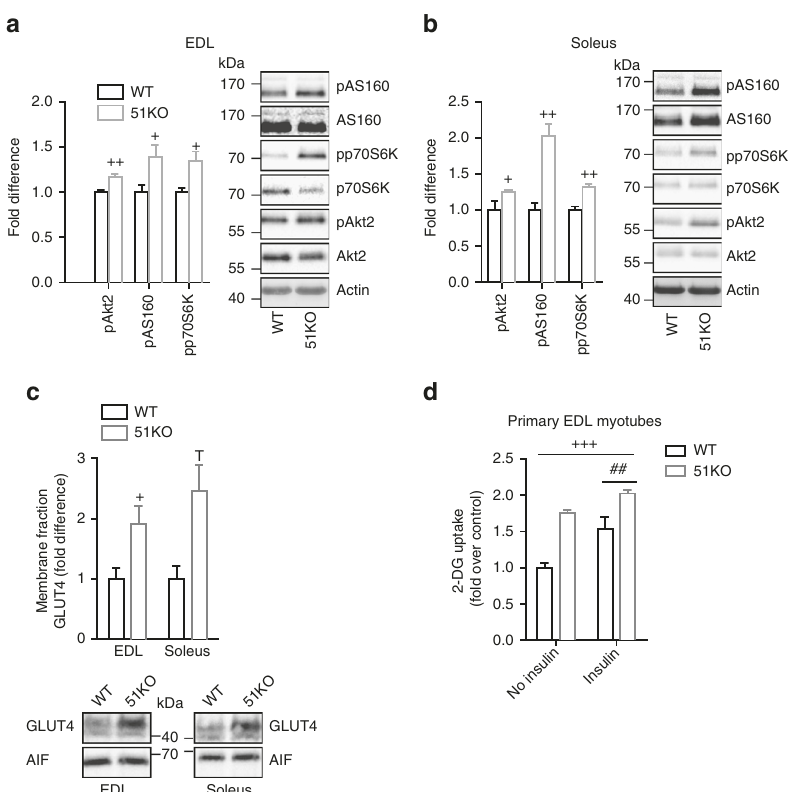
Fig. 4 FKBP51 affects insulin signaling and consequently glucose uptake. a , b Insulin signaling was enhanced in EDL ( a ) and soleus ( b ) skeletal muscles of 51KO mice compared to WT mice as assessed by pAKT2, pAS160, and pp70S6K protein expression. c Following subcellular fractionation to isolate the plasma membrane compartment, we observed increased GLUT4 expression in skeletal muscle membrane fractions of 51KO mice. d In primary EDL myotubes, loss of FKBP51 heightened glucose uptake under both no insulin and insulin-stimulated states. For quanti fi cation of phosphorylated protein, n = 6 per group. For GLUT4 membrane localization, n = 3 per group. For glucose uptake experiments, 3 wells for each condition were measured. The data are expressed as relative fold change compared to wild-type condition ± SEM. + P < 0.05, ++ P < 0.01, +++ P < 0.001, ## P < 0.01, two-tailed t tests for a – d , two- way ANOVA for e ; + signi fi cant genotype effect, # signi fi cant insulin effect, T trend for genotype. Supplementary Fig. 12 shows uncropped gel